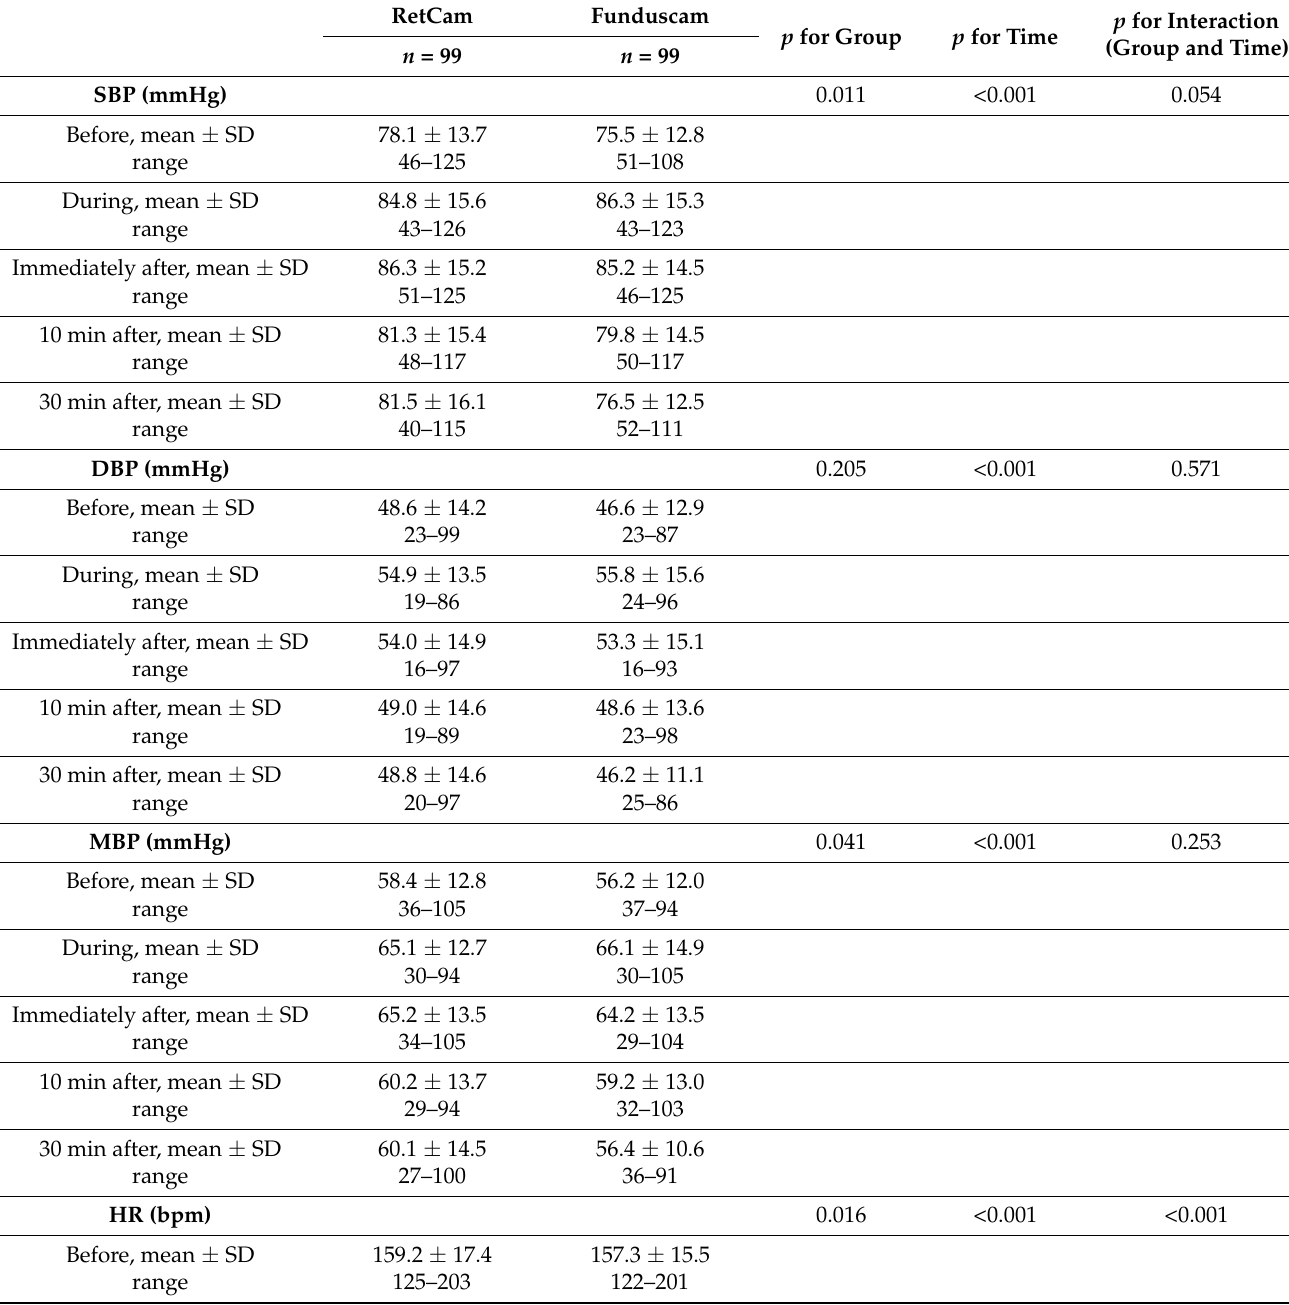
Table 4. Systemic parameters during different